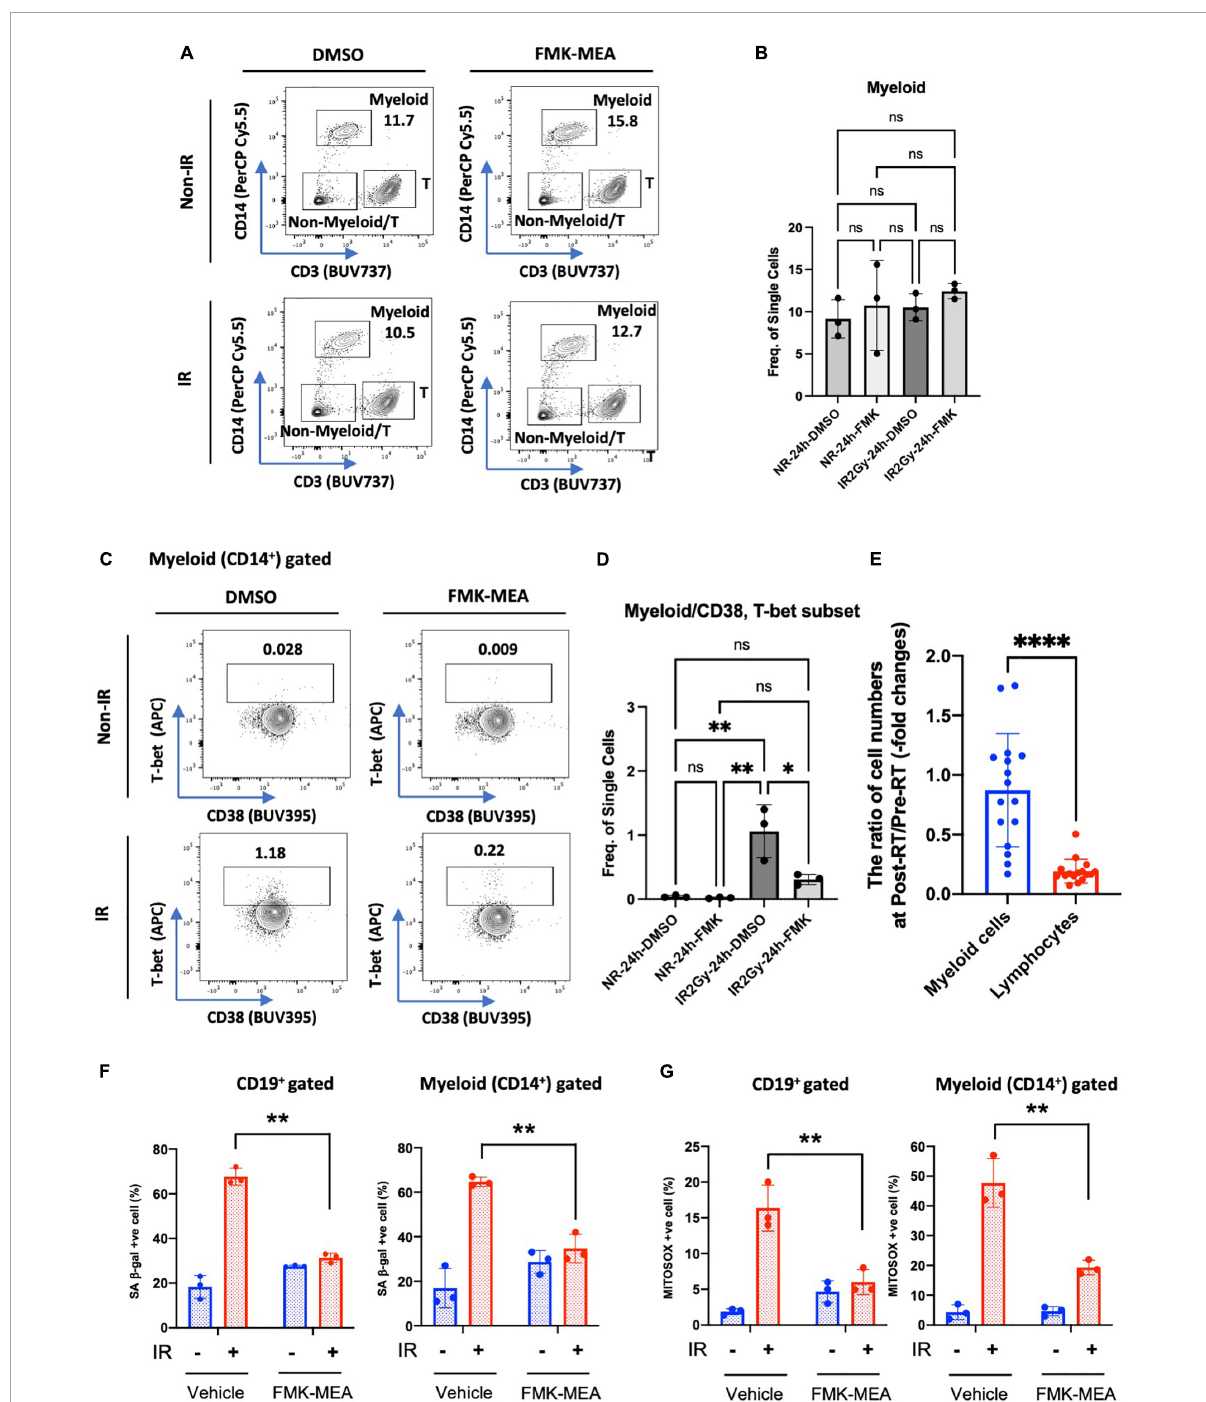
FIGURE7 IR-induced CD38 + /T-bet + myeloid cells via p90RSK activation. (A) Representative FACS plots of myeloid T-cell distribution are depicted. (B) Myeloid cell frequency 24 h after irradiation/non-irradiation with/without FMK-MEA (10 µ M). (C,D) Representative FACS plots (C) and their frequency (D) of T-bet expression in CD14 + myeloid cells in each condition. N = 3 for each group, and the experiments were done more than twice. Mean ± SD, ∗ p < 0.05 and ∗∗ p < 0.01. (E) The ratio of cell numbers [myeloid cells (Blue) and lymphocytes (Red) ] at pre-RT and post-RT. Mean ± SD, ∗∗∗∗ p < 0.001. (F,G) PBMCs were exposed to IR (2 Gy) with pre-treatment of FMK-MEA (10 µ M) or vehicle for 1 hr. Senescent B cells and monocytes from PBMCs were measured using the C12FDG, a fluorogenic substrate for SA- β -galactosidase. Data shows the Quantification of positive C12FDG + cells from CD19 + (Left) CD14 + (Right) cells. (G) Mitochondrial superoxide production was measured using the Mitosox dye in CD19 + (left) CD14 + (right) cells. Mean ± SD, n = 3, ∗∗ p <